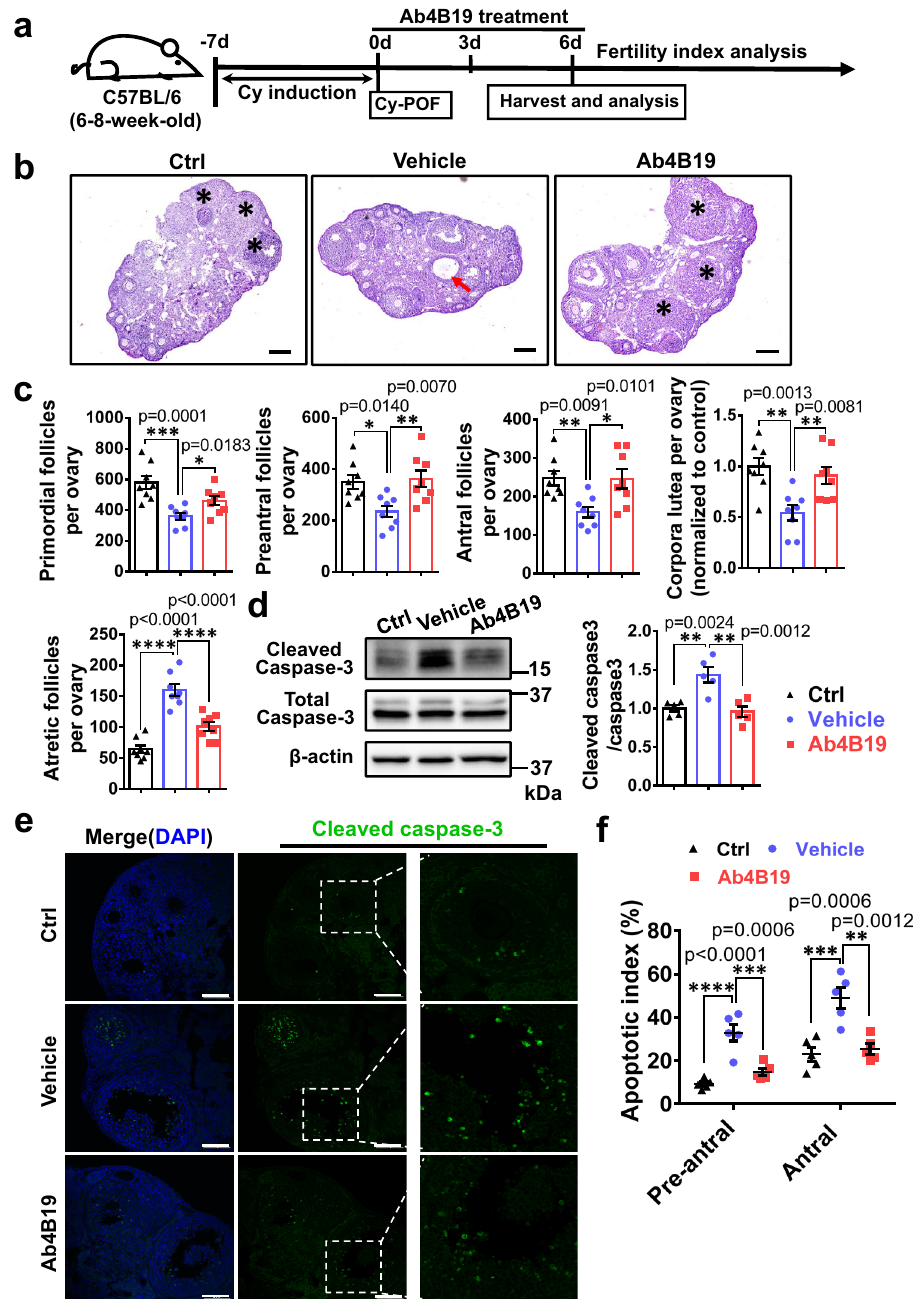
Fig. 5 Alleviation of ovarian defect and gonadotoxicity by Ab4B19 in Cy-POF model. a Experimental design of Ab4B19 treatment and analysis in Cy-POF mice. b H&E staining ovaries (midline sections) harvested from a normal female mouse (left) or a Cy-POF mouse treated with vehicle (center) or Ab4B19 (right) for 6 days. Asterisks: the corpora lutea; Red arrow: atretic ovarian follicle. Scale bars, 200 μ m. c Quanti fi cation of primordial, pre-antral, antral follicles, atretic follicles, and corpora lutea per ovary in normal mice (Ctrl), and Cy-POF mice treated with vehicle or Ab4B19. N = 8 ovaries per each condition. Unless stated otherwise, statistical analyses for comparison among three or more groups in this and all the following fi gures were carried out using one-way ANOVA, followed by Dunnett ’ s multiple comparisons tests. d Western blotting showing the expression of cleaved and total caspase-3. The apoptotic level was determined by the normalized ratio of the cleaved to total caspase-3. N = 5 mice per group. e Immuno fl uorescence images of ovaries stained with cleaved caspase-3 antibody (Green: cleaved caspase-3, Blue: DAPI). Images in the red frames in the center row are magni fi ed and shown on the right. Scale bars, 200 μ m. f Quanti fi cation of apoptosis in pre-antral and antral follicles. Apoptosis index was expressed as apoptotic/total follicles ( N = 5 mice per group). Data were all presented as mean ± SEM. Statistical analyses were carried out using one-way ANOVA followed by the Dunnett ’ s multiple comparisons test ( c , d , f ) (* P < 0.05; ** P < 0.01; *** P < 0.001; **** P < 0.0001). Source data are provided as a Source Data fi